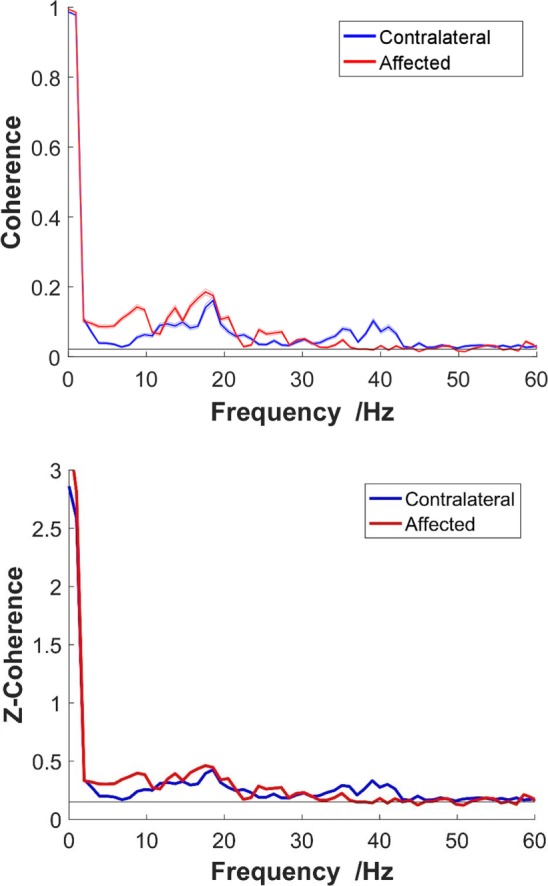
Top: non-standardized coherence; bottom: z-coherence. An exemplar frequency-coherence plots from a representative stroke participant at 40% maximum voluntary contraction. The solid thick red line represents the coherence of the affected side, and the blue line represents the contralateral side. Thin lines present SE.